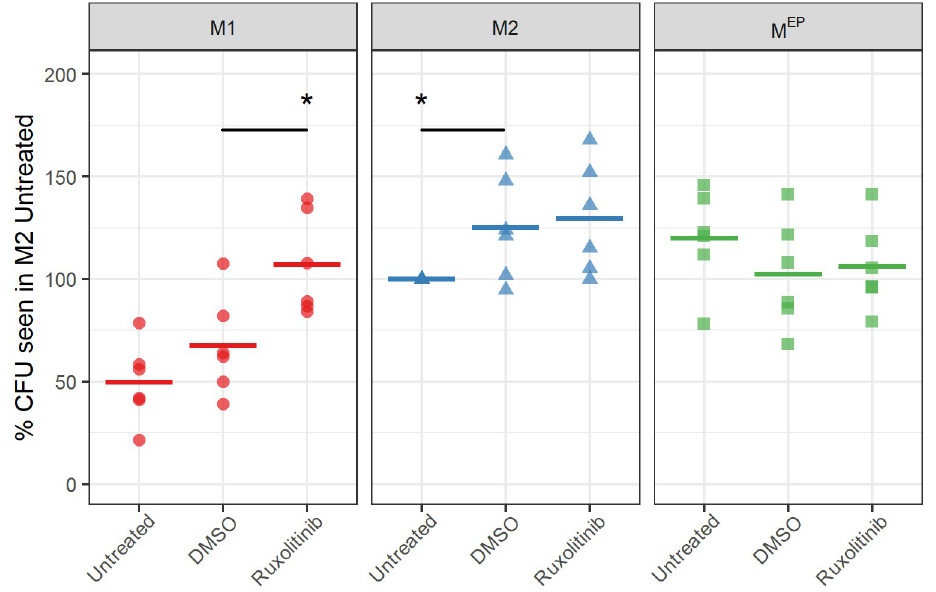
Fig 6. Effect of JAK inhibition during polarization on Salmonella resistance. Color and shape reflect polarization states as labelled and is used for emphasis. For each donor, data were expressed relative to CFU in untreated M2 macrophages from the same donor; lines represent the medians of 6 biological replicates (BR). 100% reflects a median 3.4x10 7 CFU. Significance was determined relative to the DMSO control for each polarization state. Statistics were calculated by Wilcox test, with p-values indicated as � ( <